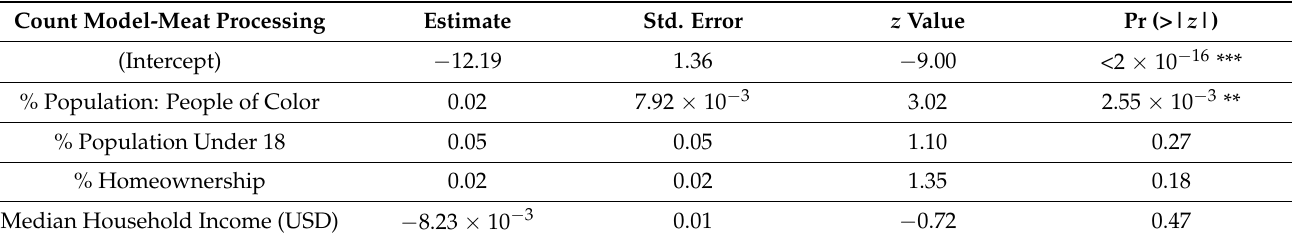
Table 4. Zero-inflated Poisson Regression Modeling for MD Meat Processing Facilities.